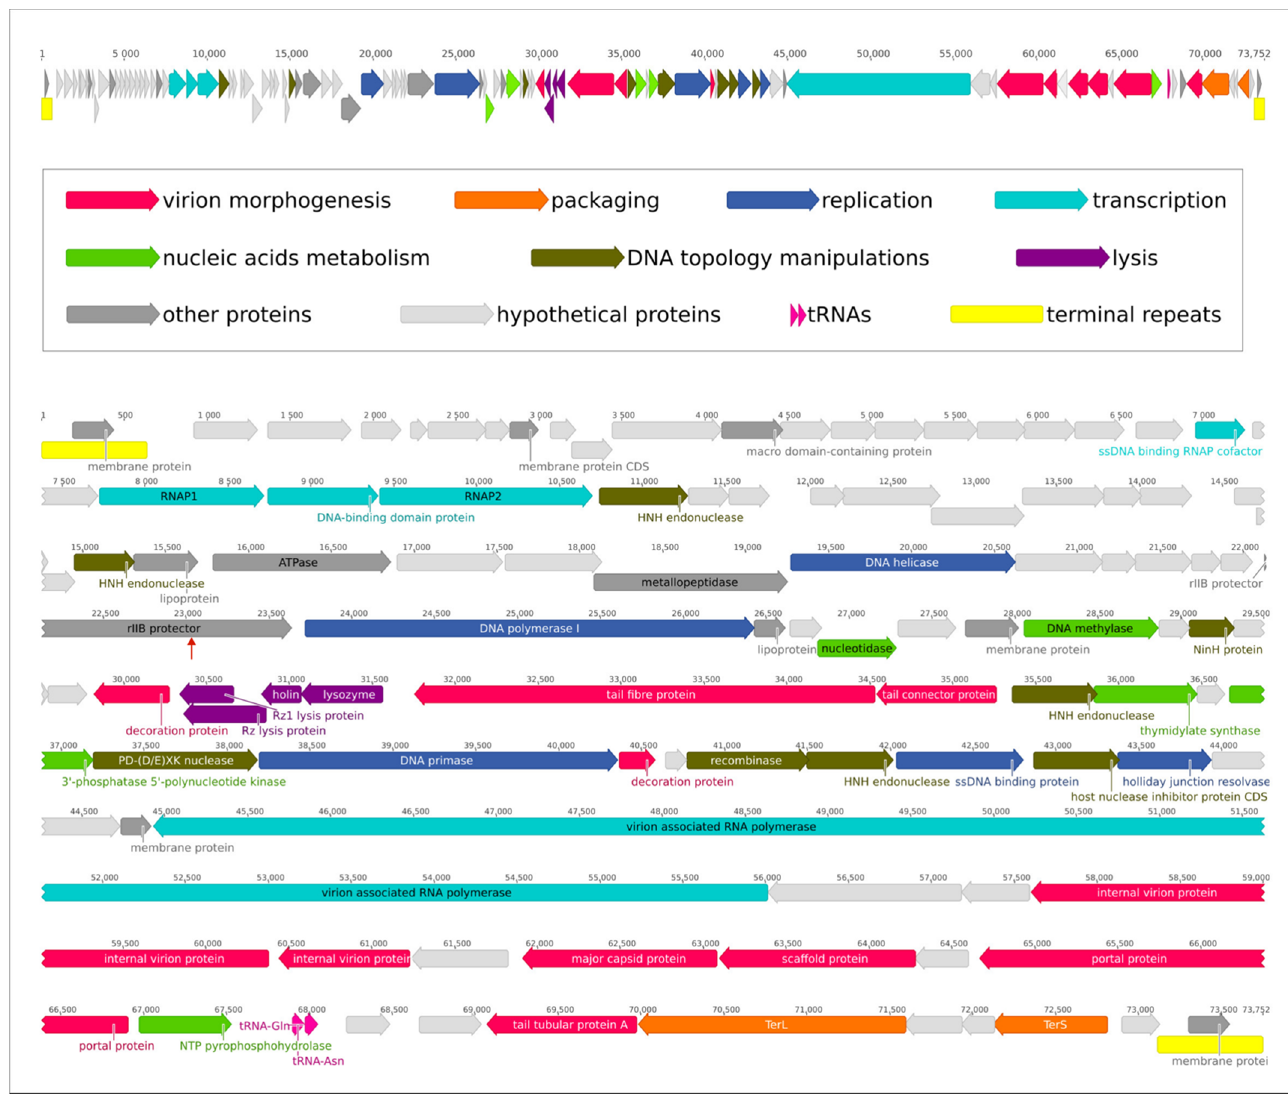
Figure 2. Genetic map of Pectobacterium phage Possum. Upper panel: the basic scheme of the genome. Lower panel: the genetic map and putative functions of genes. The 15 bp-long insert in Possum’s rIIB protector from prophage-induced early lysis gene is indicated by a red vertical